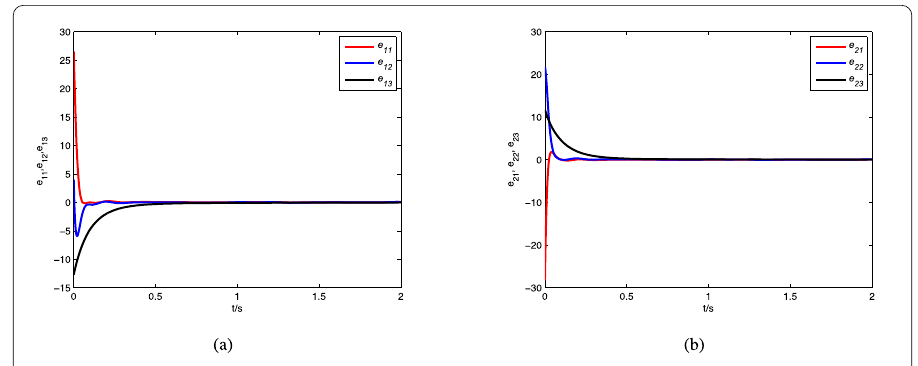
Figure 4 The error dynamics of synchronization among three fractional-order Lü